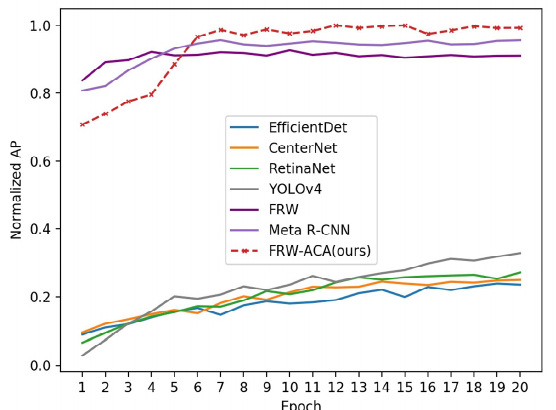
Figure 8. Comparison of learning speed. We plot the normalized AP against the number of training epochs.